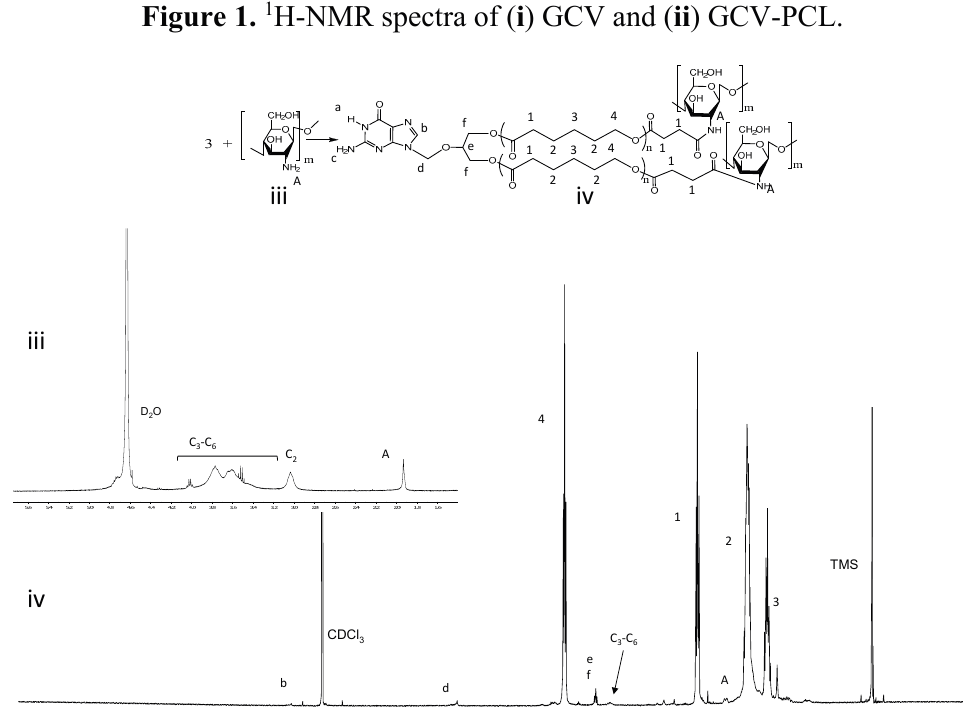
Figure 2. 1 H-NMR spectra of ( iii ) chitosan and ( iv )